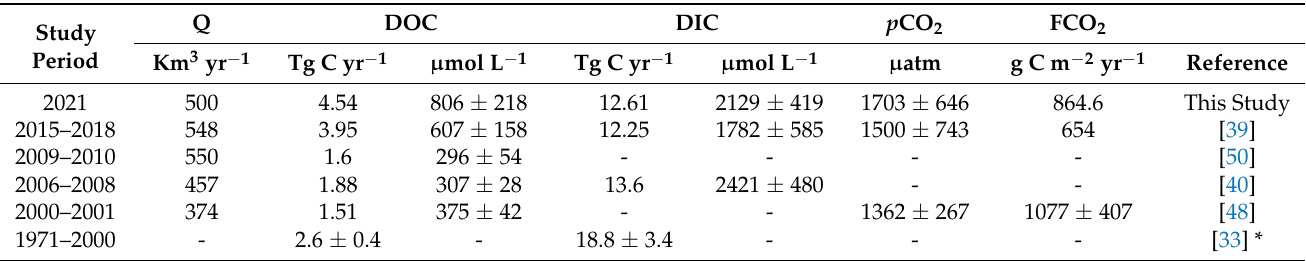
Table 4. Comparison of previous studies of dissolved carbon and outgassing from the Missis- sippi River.